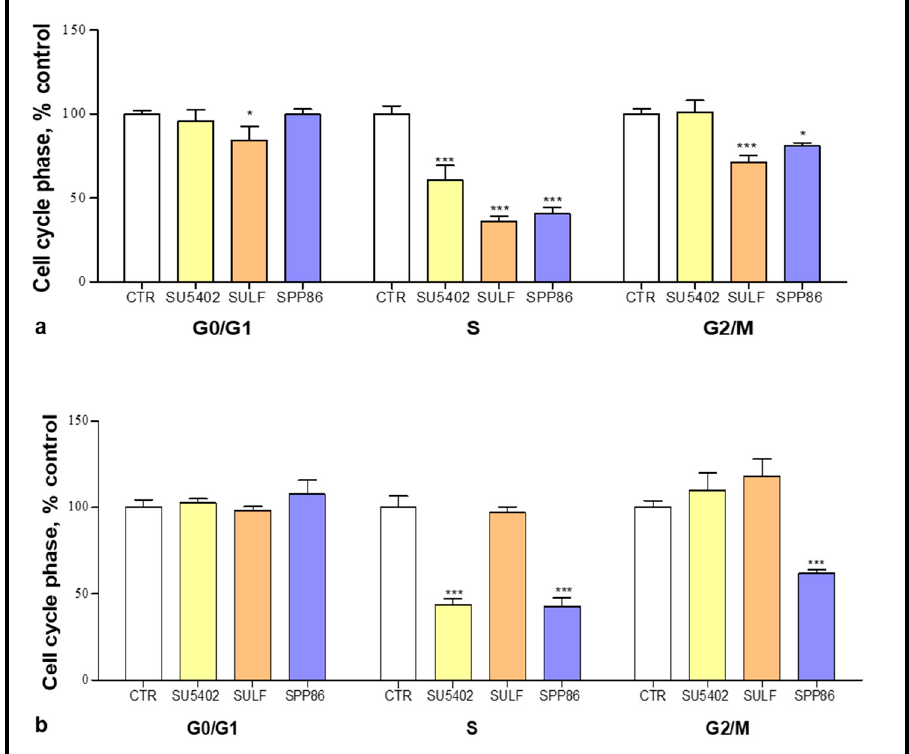
Figure 3. Cell cycle analysis after 6 days of incubation with SU5402, sulfatinib (SULF) and SPP86 in TT ( a ) and MZ-CRC-1 ( b ) cell lines. Cells were detected by FACS analysis after staining with propidium iodide. CTR values have been set to 100%. Values represent the mean ± standard error of the mean of at least 3 independent experiments. *: p < 0.05, ***: p < 0.001, CTR: control, SULF: sulfatinib.